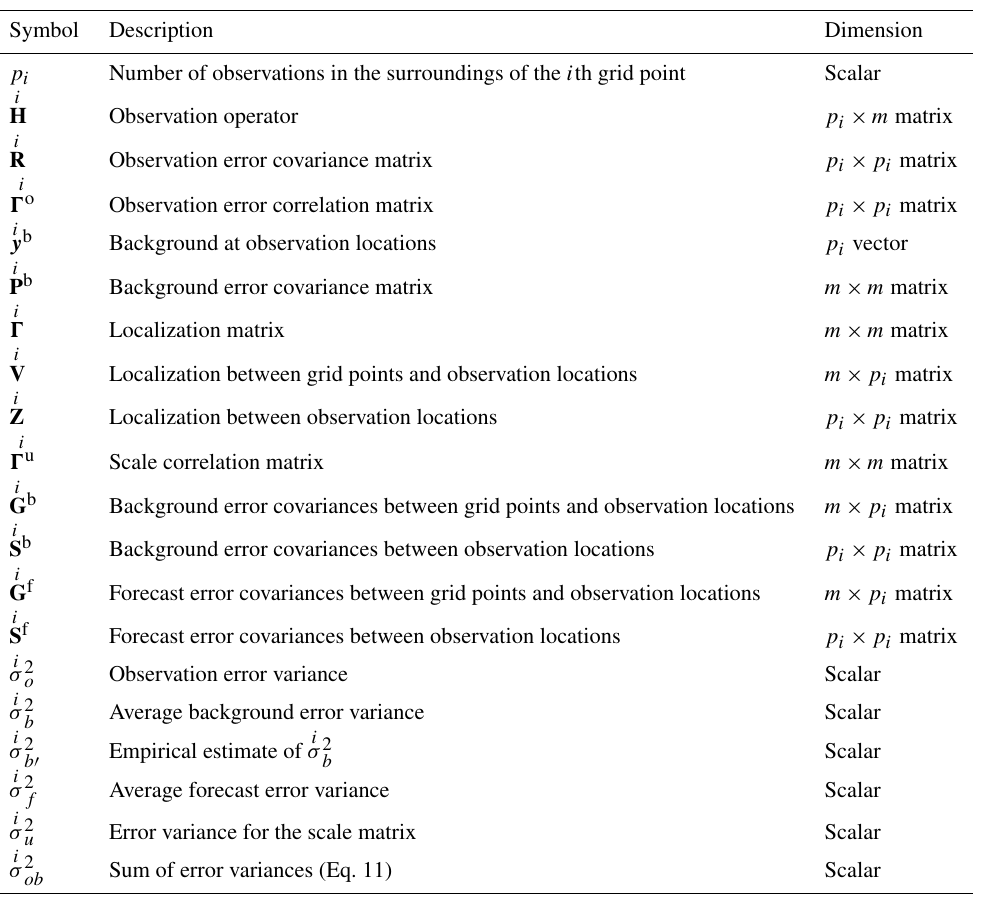
Table 2. Overview of variables and notation for local variables. All variables are specified in the transformed space. All the vectors are column vectors unless otherwise specified. If X is a matrix, X i is its i th column (column vector), and X i, : is its i th row (row